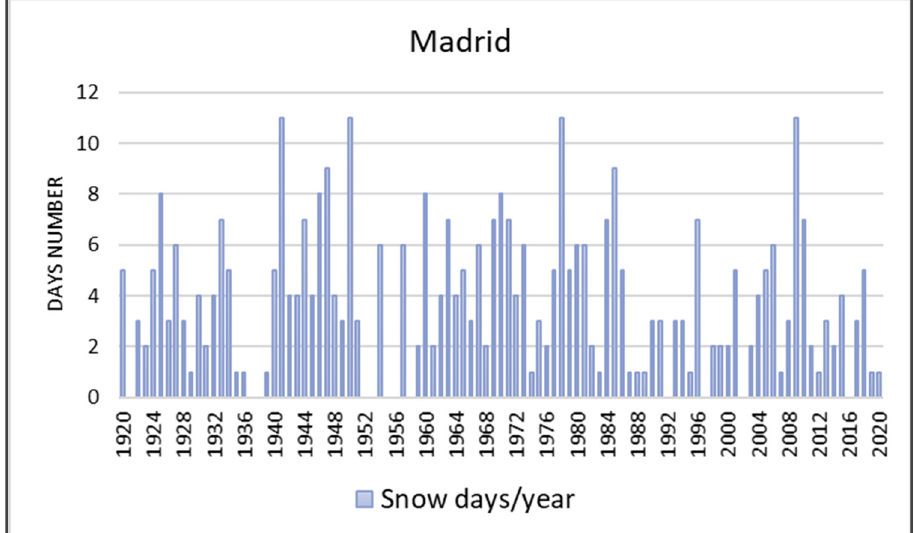
Figure 2. Snow days in Madrid during the period: 1920–2020.